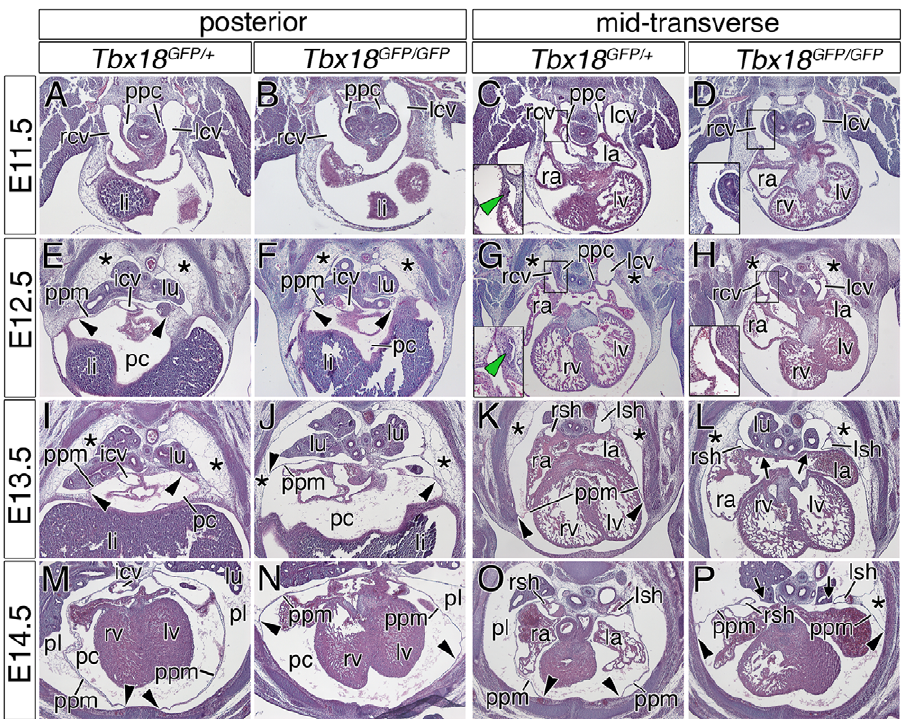
Figure 3. PPM development in control and Tbx18 -deficient embryos. (A–P), Histological analysis by haematoxylin and eosin stainings of PPM development was performed on transverse sections of a posterior and a mid-transverse section plane of control and Tbx18 -deficient hearts from E11.5 to E14.5. Magnifications (C, D, G, H) highlight the sinuatrial mesenchymal ridges that protrude into the PPCs in control embryos at E11.5 and E12.5, and their absence in Tbx18 -deficient embryos, respectively. Genotypes and stages are as indicated. Asterisks highlight the subcoelomic lateral body wall mesenchyme; black arrowheads mark the attachment point of the PPMs to the lateral body wall; black arrows point to the remaining PPCs; and green arrowheads mark the mesenchymal ridge that is necessary for the closure of the PPCs. icv, inferior cardinal vein; la, left atrium; lcv, left cardinal vein; li, liver; lu, lung; lsh, left sinus horn; lv, left ventricle; pc, pericardial cavity; ppc, pericardioperitoneal canal; pl, pleural cavity; ppm, pleuropericardial membrane; ra, right atrium; rcv, right cardinal vein; rsh, right sinus horn; rv, right ventricle.